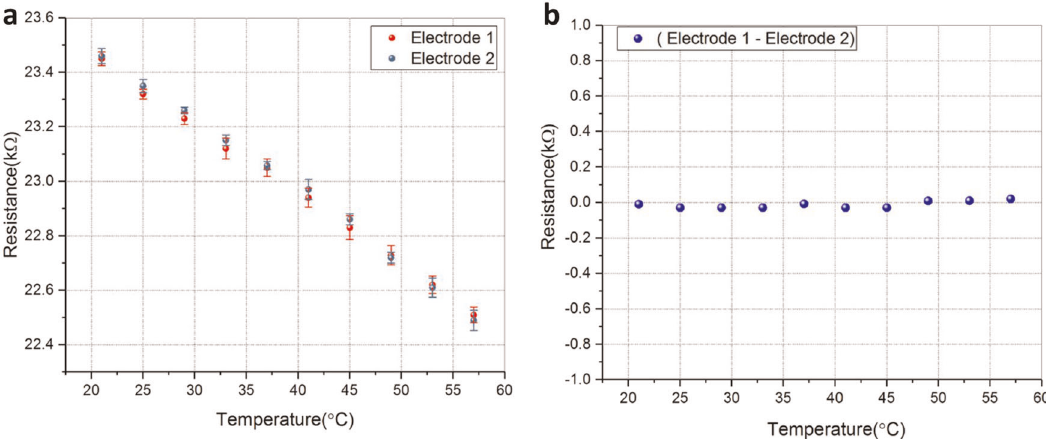
Fig. 8 a The resistance of the LIG temperature sensor as a function of temperature. Each data point represents the average of three measured values; each error bar connects the maximum and the minimum values. b The result of subtracting the average output signals of electrodes from each other